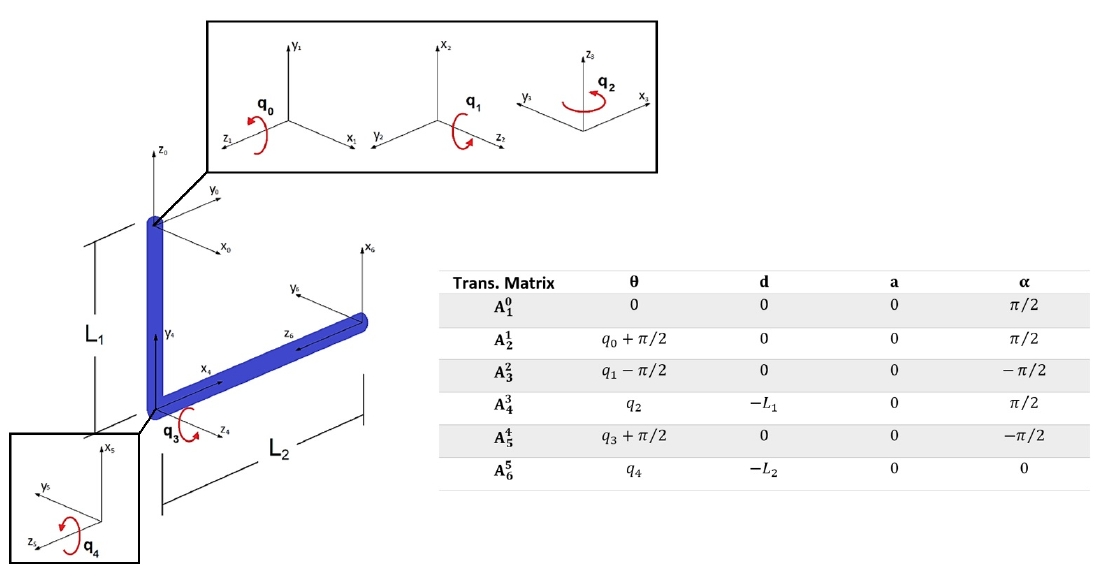
Figure 4. Reference systems and DH parameters of the proposed